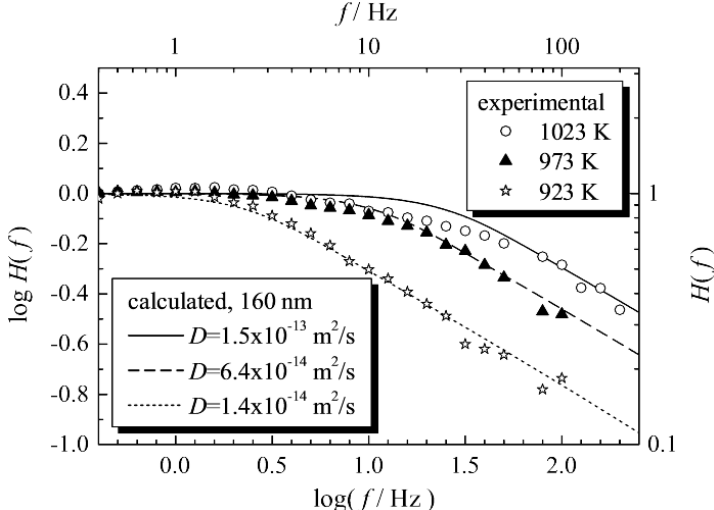
Figure 10. Calculated and measured results for a porous ceria thick film with average particle size of 160 nm obtained by the pressure modulation method (PMM). From [25], reprinted with permission from